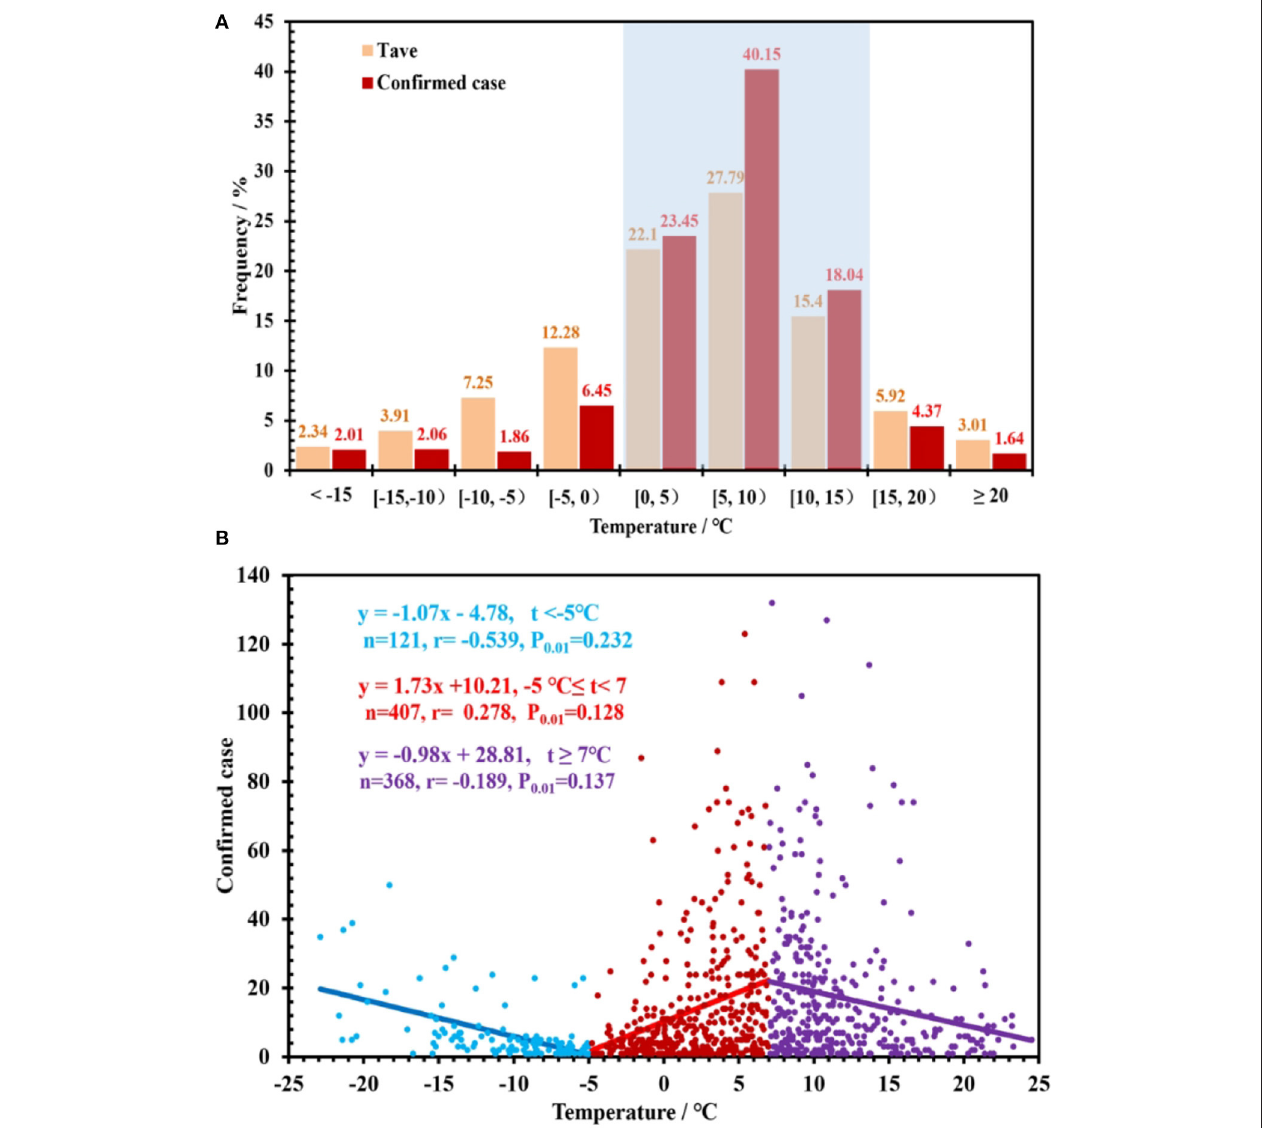
FIGURE 3 | Frequency distribution (A) and linear correlation (B) between daily average air temperature ( T avg ) and confirmed cases in different air temperature ranges.